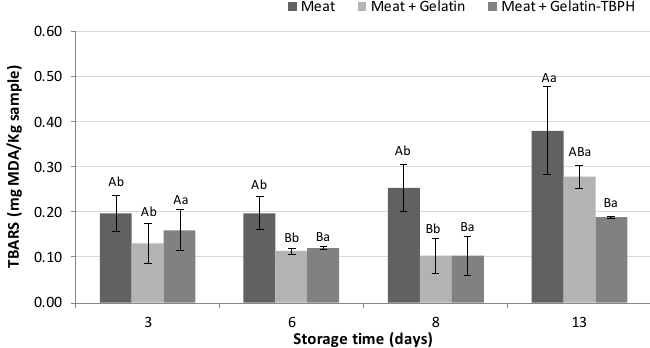
Figure 5. Lipid oxidation of uncoated and coated meat samples during storage (3, 6, 8, and 13 days). A capital letter indicates significant differences between samples within the same day of storage, whereas a lower case letter indicates significant differences between days of storage within the same sample ( p < 0.05).